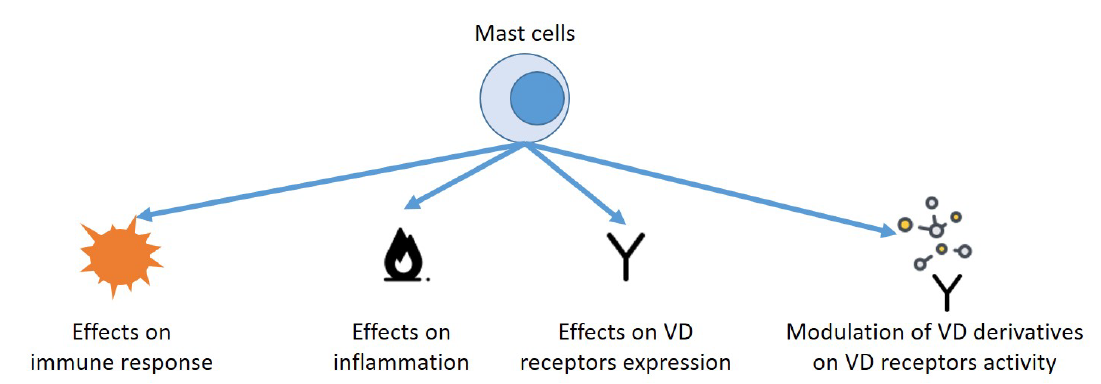
Figure 5. Effects of mast cells on skin disease.